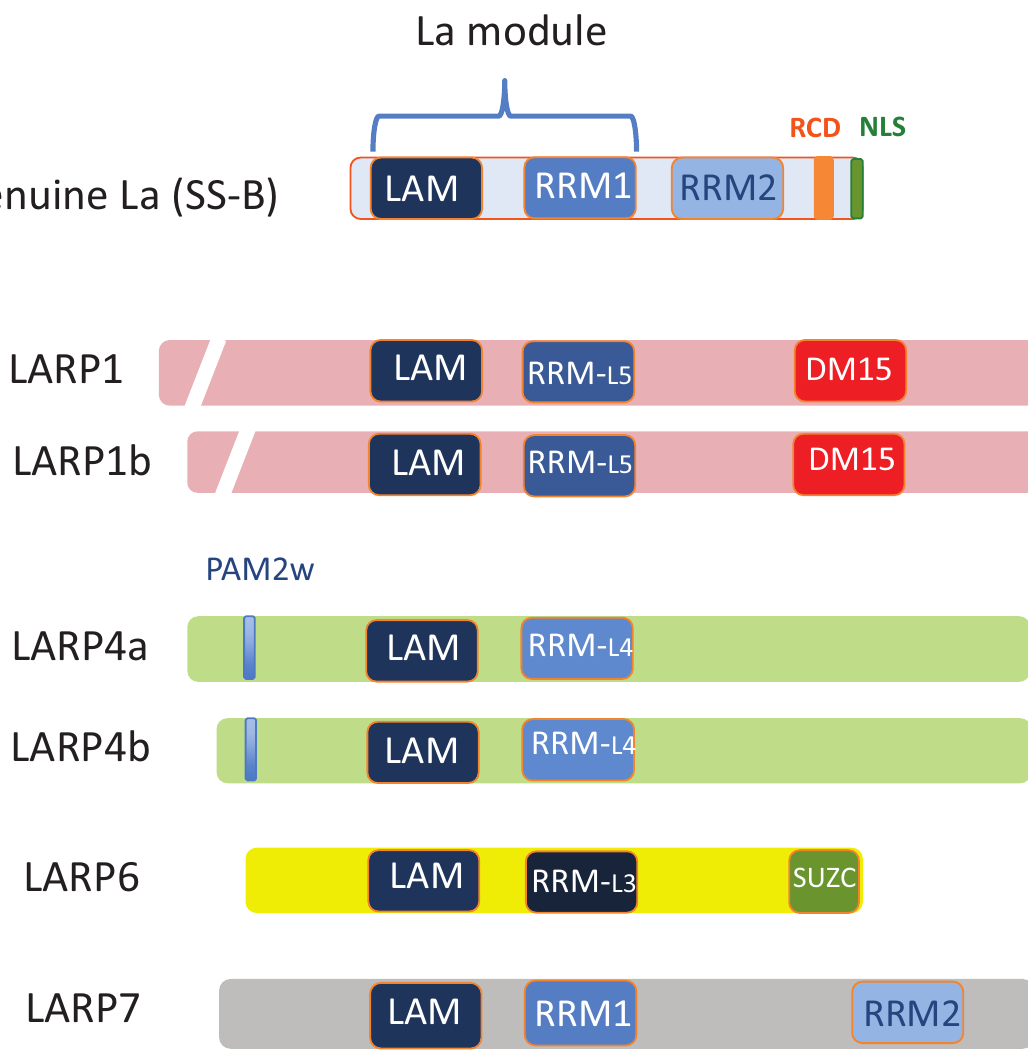
Figure 1. The principal domains common to members of the LARP protein